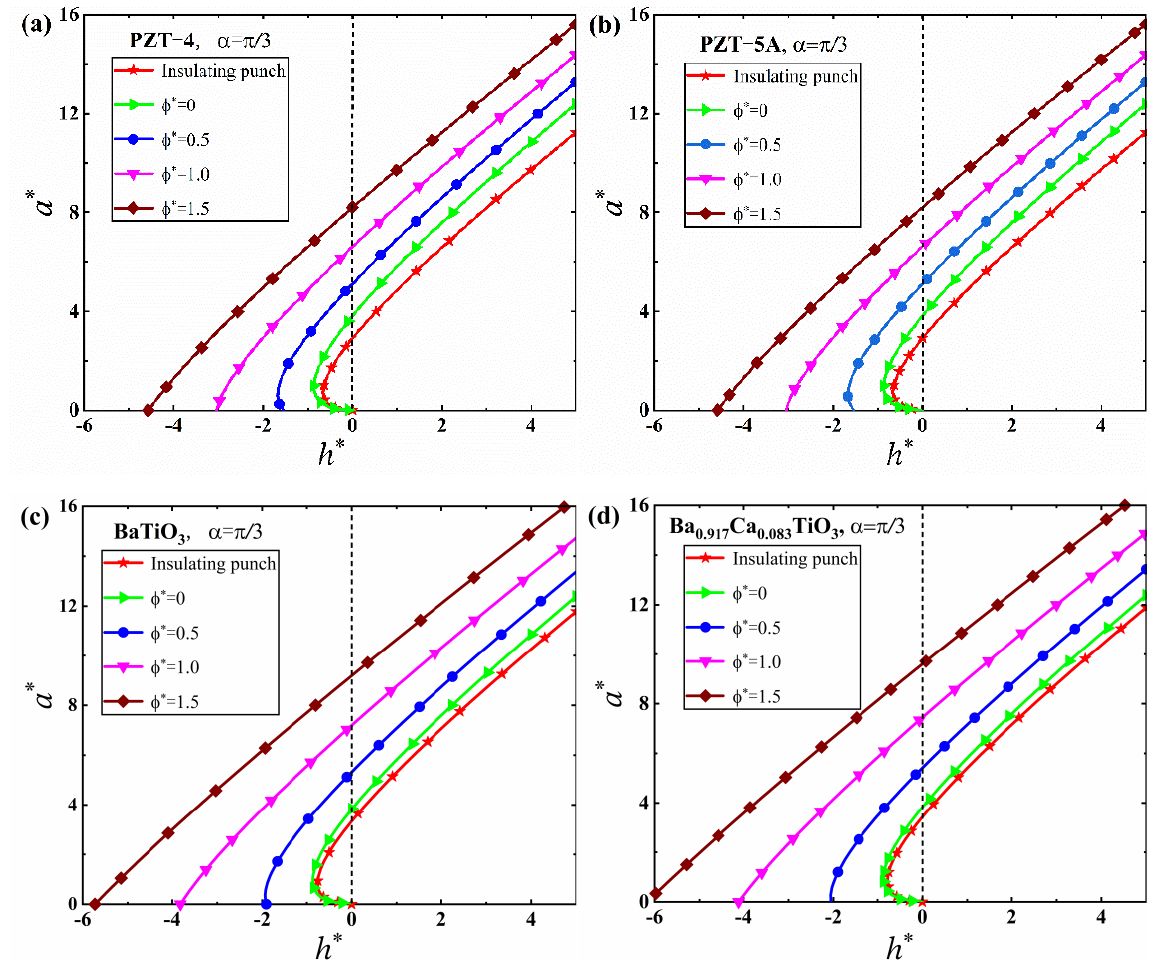
Figure 9. The dimensionless contact radius, a ∗ , as a function of the dimensionless indentation depth, h ∗ , at a fixed value of α = π /3 for the JKR model. ( a ) PZT-4. ( b ) PZT-5A. ( c ) BaTiO 3 . ( d ) Ba 0.917 Ca 0.083 TiO 3 .